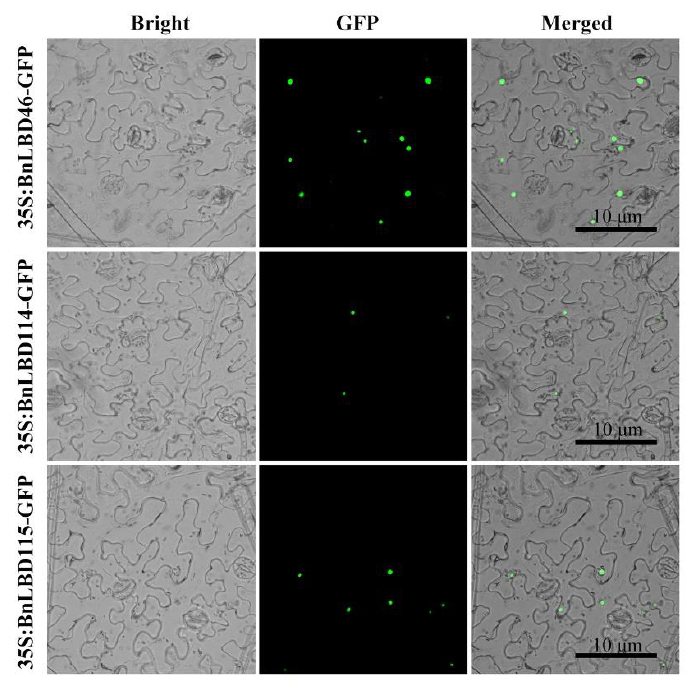
Figure 1. Subcellular localization of BnLBD46/114/115-GFP. GFP fluorescence is shown in green. Bars = 10 μm. LBD, LATERAL ORGAN BOUNDARIES (LOB)-domain; GFP, green fluorescent protein.